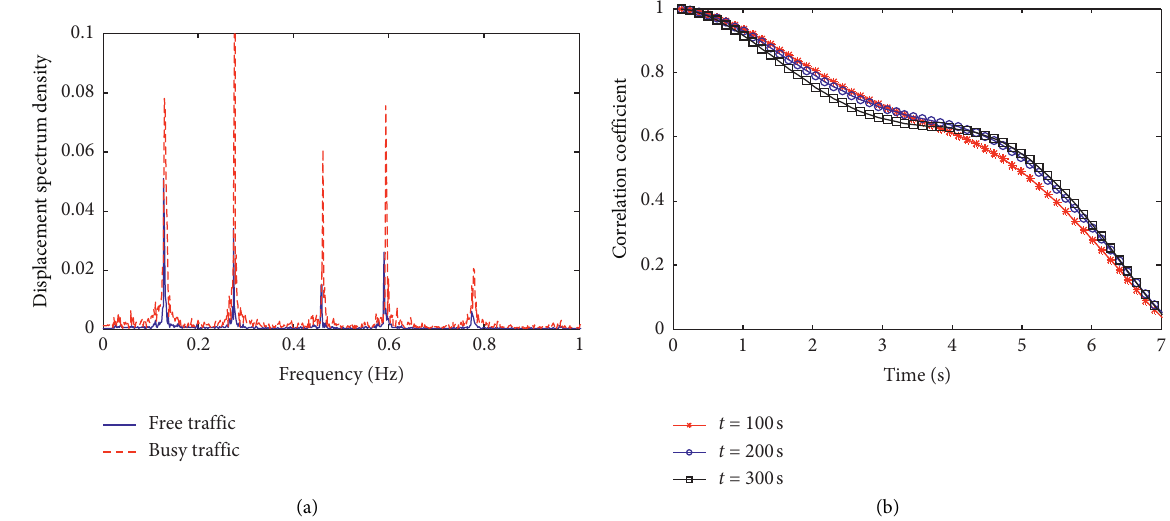
Figure 14: Bride dynamic deflections in frequency domain: (a) spectrum density; (b) correlation coefficient.